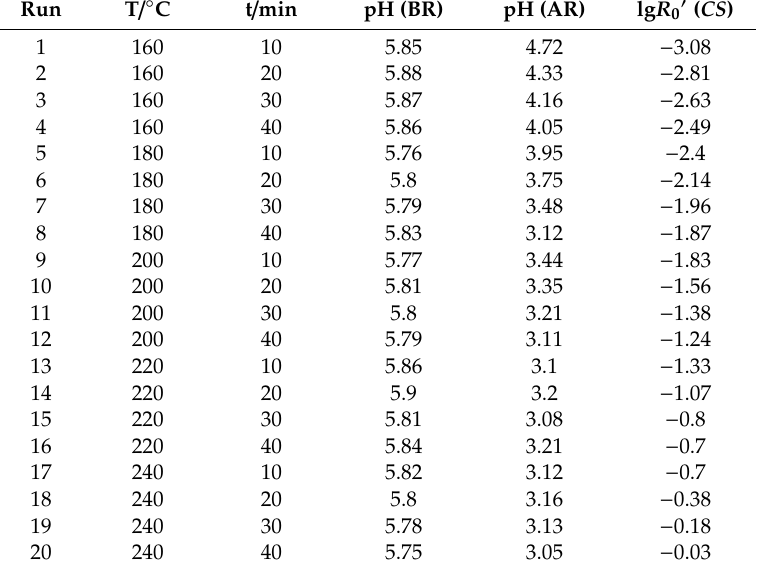
Table 1. Pretreatment schemes with 1 × 10 − 5 mol / L FeCl 2 , pH before and after reaction and CS . Run T / ◦ C t / min pH (BR) pH (AR) lg R 0 (cid:48) ( CS